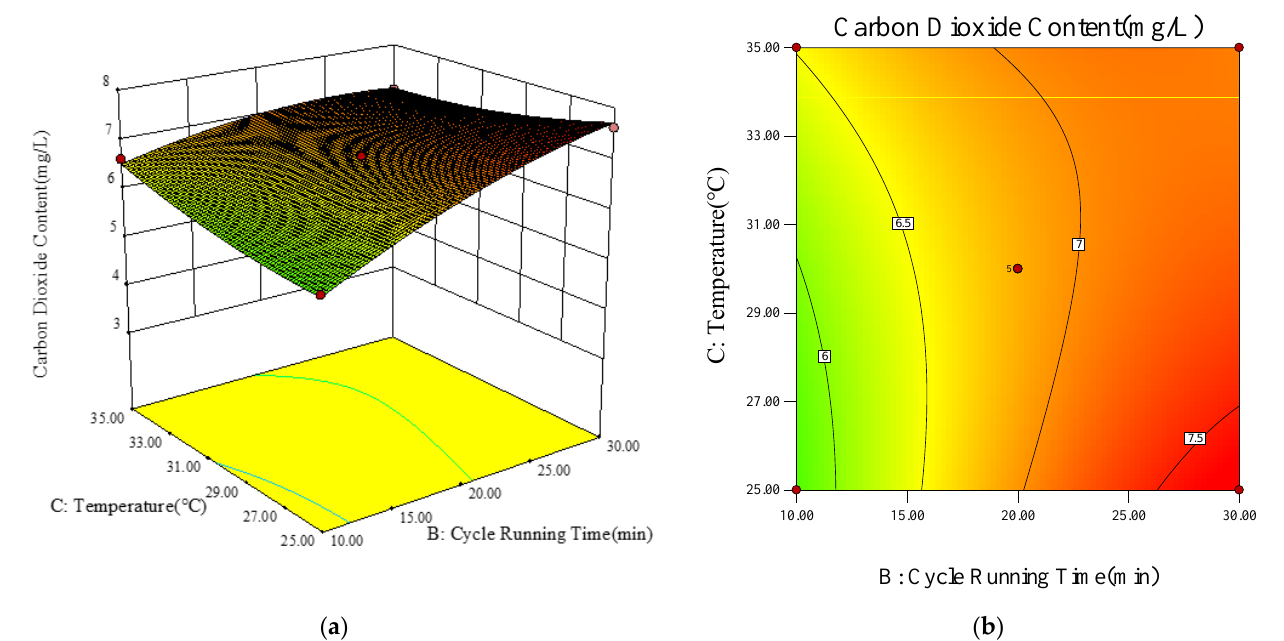
Figure 8. The interaction between the inlet water temperature and the generator running time: ( a ) response surface and ( b ) contour lines.